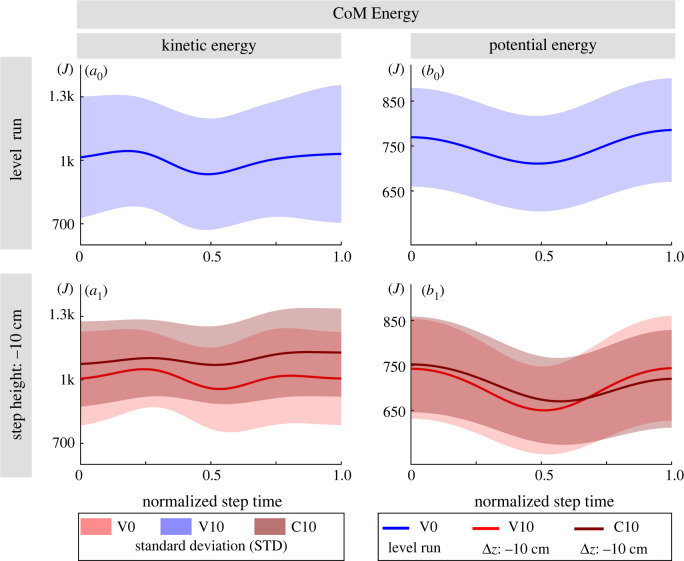
This figure is an extension of figures 10 and 11, with the difference that the standard deviation is plotted as patches instead of the standard error.